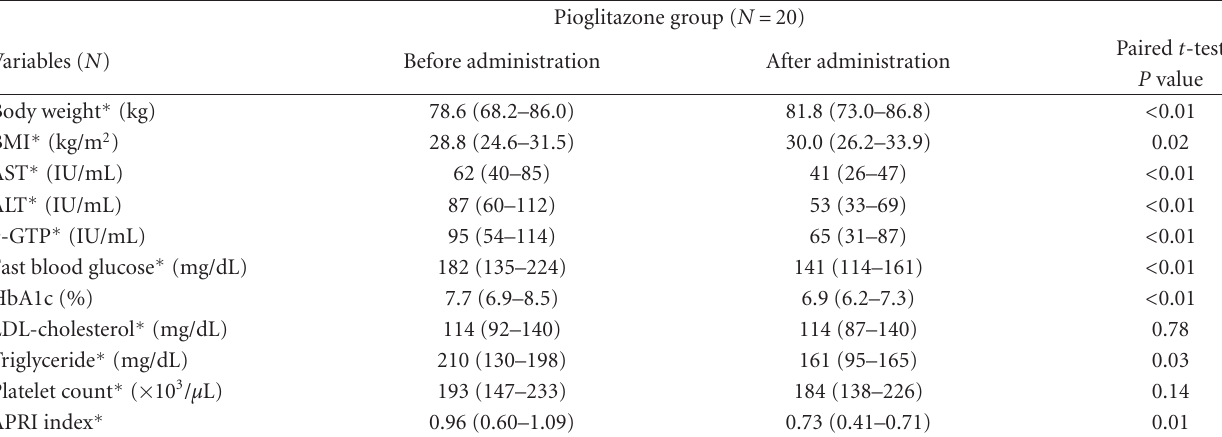
Table 4: Change of parameters after administration of